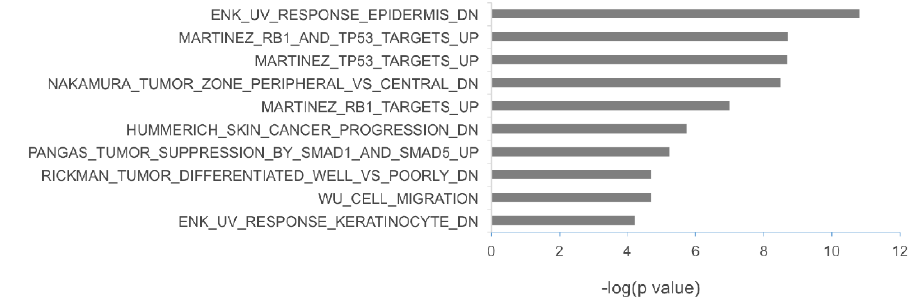
Figure 5. Enriched gene sets of putative targets of miRNAs upregulated in metastatic melanoma. The conserved target sites of miR ‐ 17 ‐ 5p, miR ‐ 19a ‐ 3p, miR ‐ 149 ‐ 5p, miR ‐ 21 and miR ‐ 126 ‐ 3p were mapped to the 3 ‐ UTRs of a panel of genes that have been associated with melanoma progression according to TargetScan V6.2. Gene set enrichment analysis of putative miRNA targets was conducted by using the Molecular Signatures Database v5.0.